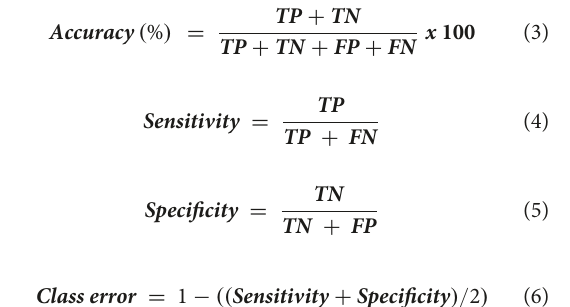
algorithm using a second order polynomial and 15